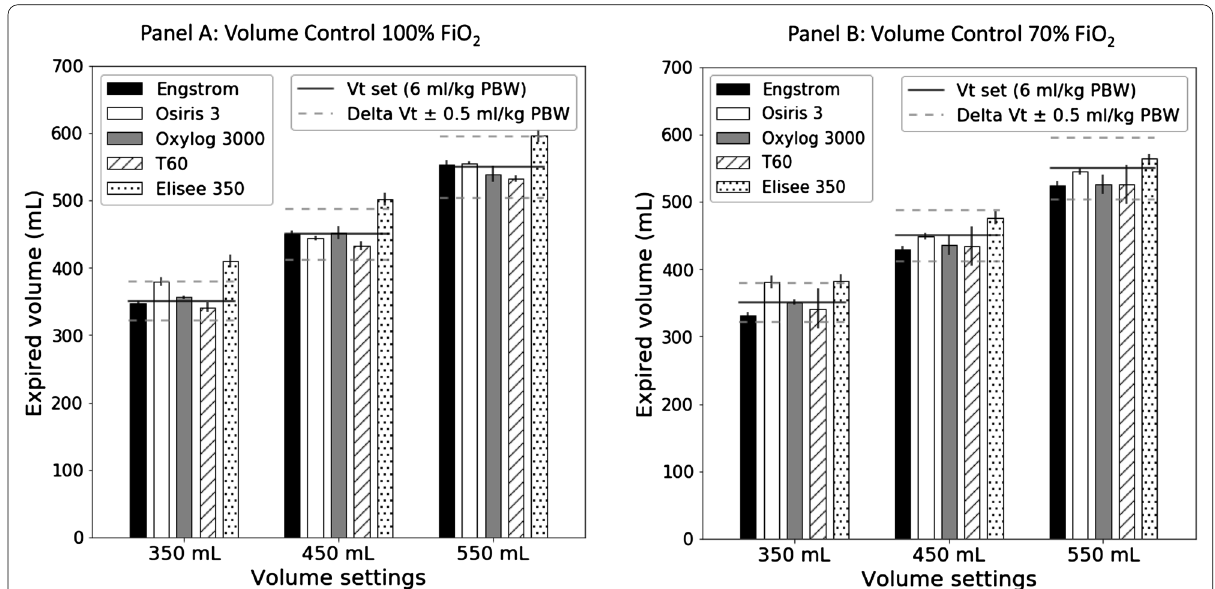
Fig. 3 Tidal Volume delivery in volume control ventilation in static conditions. a The histogram represents the mean expired volumes measured for each ventilator according to the three Vt set in 100% FiO 2 . The average was computed over the four conditions of resistance (15 cmH 2 O/l/s), compliance (20–50 ml/cmH 2 O) and PEEP (10–15 cmH 2 O). The three tidal volumes tested were chosen to cover 6 ml/kg PBW, with 350, 450 and 550 ml corresponding to 6 ml/kg PBW for respectively 58, 75 and 92 kg PBW. Limits of acceptable ventilation are displayed with dotted lines and defined as a volume change within 0.5 ml/kg PBW, which corresponds to a Vt between 5.5 and 6.5 ml/kg PBW. b The histogram represents the ± mean expired volumes measured for each ventilator according to the three Vt set in 70% FiO 2 . The average was computed over the four conditions of resistance (15 cmH 2 O/l/s), compliance (20–50 ml/cmH 2 O) and PEEP (10–15 cmH 2 O)